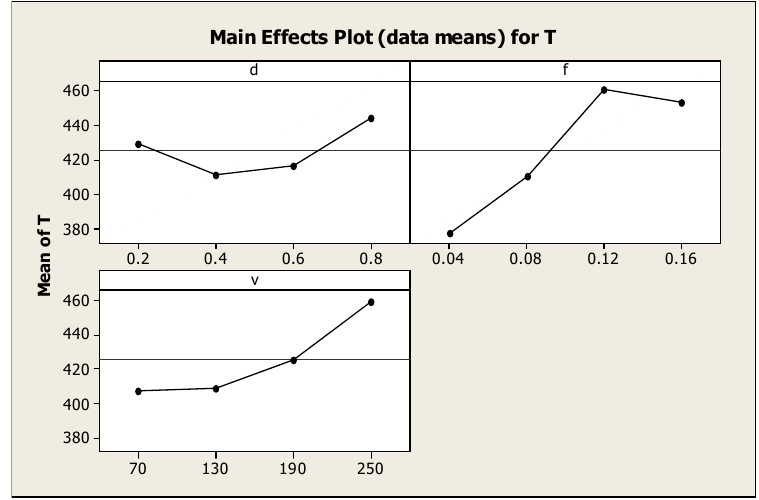
Fig. 1. Main effects plot for cutting